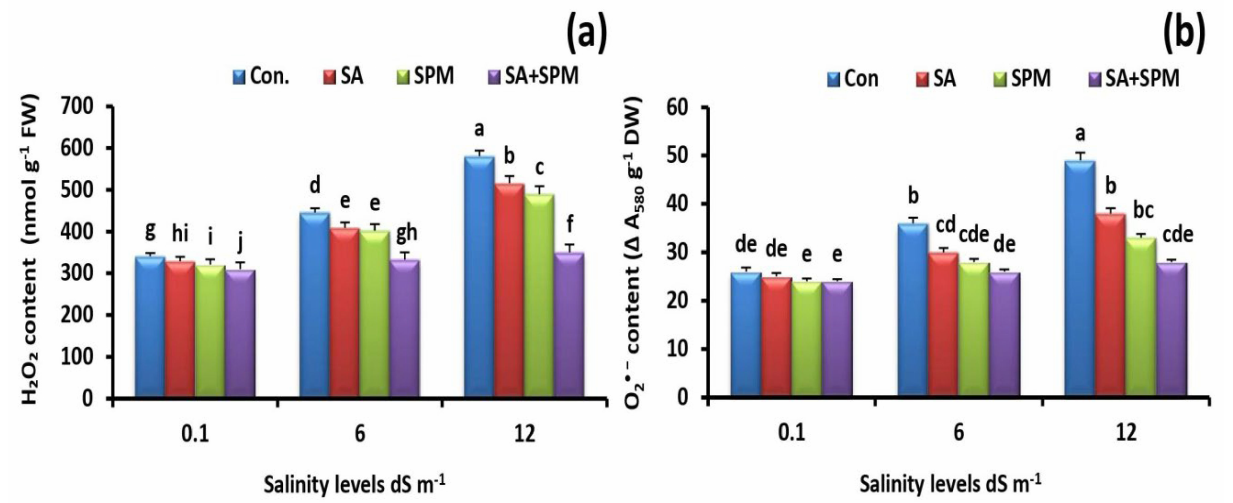
Figure 5. Effect of salicylic acid (SA) and/or spermine (SPM) foliage applications on the content of ( a ) hydrogen peroxide (H 2 O 2 ) and ( b ) superoxide (O 2 •− ) in leaves of wheat plants exposed to non-saline and saline (6.0 and 12.0 dS m − 1 ) conditions. The results showed the mean ± SE of four replicates. Different letters indicate significant differences at ( p < 0.05) level according to Duncan’s